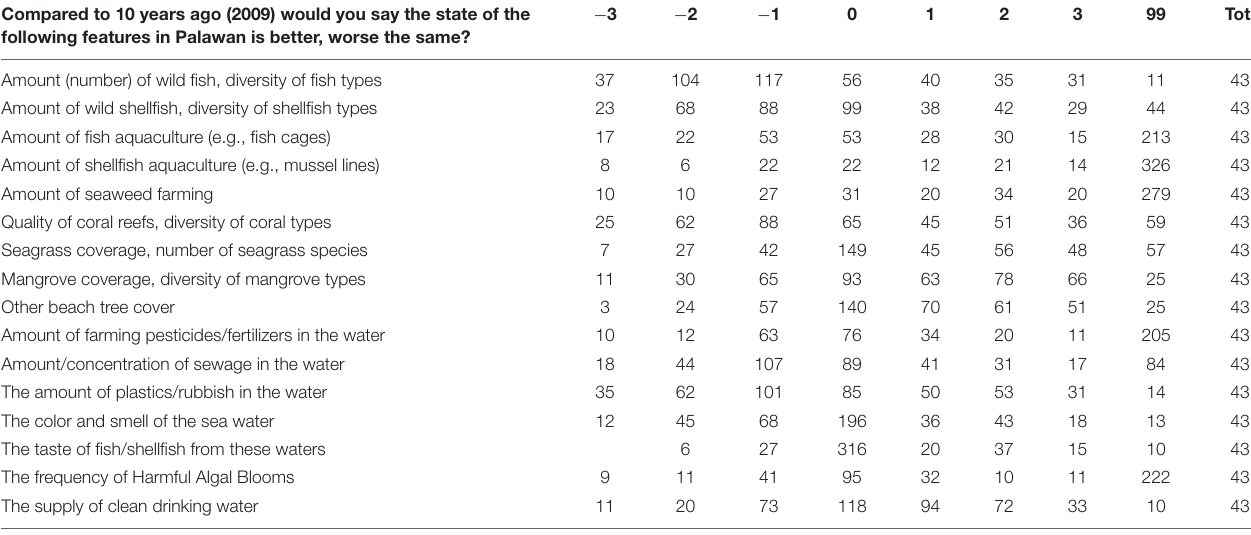
TABLE 3 | Questions and distribution of answers among respondents for present perceptions with the following response options: much worse = − 3, slightly worse = − 2, worse = − 1, the same = 0, better = 1, slightly better = 2, much better = 3, and prefer not to answer = 99. Compared to 10 years ago (2009) would you say the state of the following features in Palawan is better, worse the same?